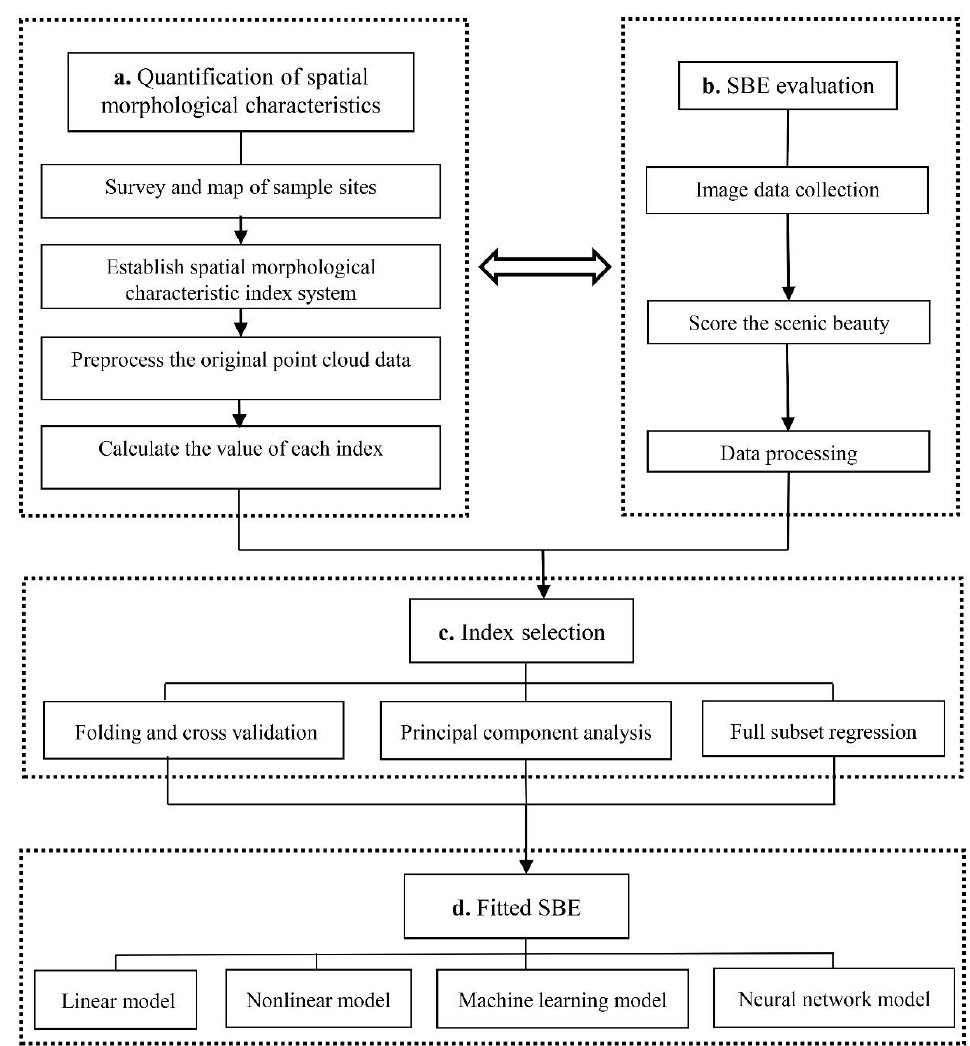
Figure 2. Technical flowchart.